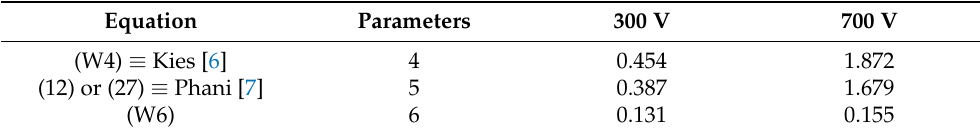
Table 3. Sums of least squares for the Weibull plots of the numbers of cycles to the destruction of the multilayer ceramic piezoelectric actuators at the temperature of 90 ◦ C for given AC biases [11] when the (W4) CDF, the Phani modification, and the (W6) CDF were used as regression